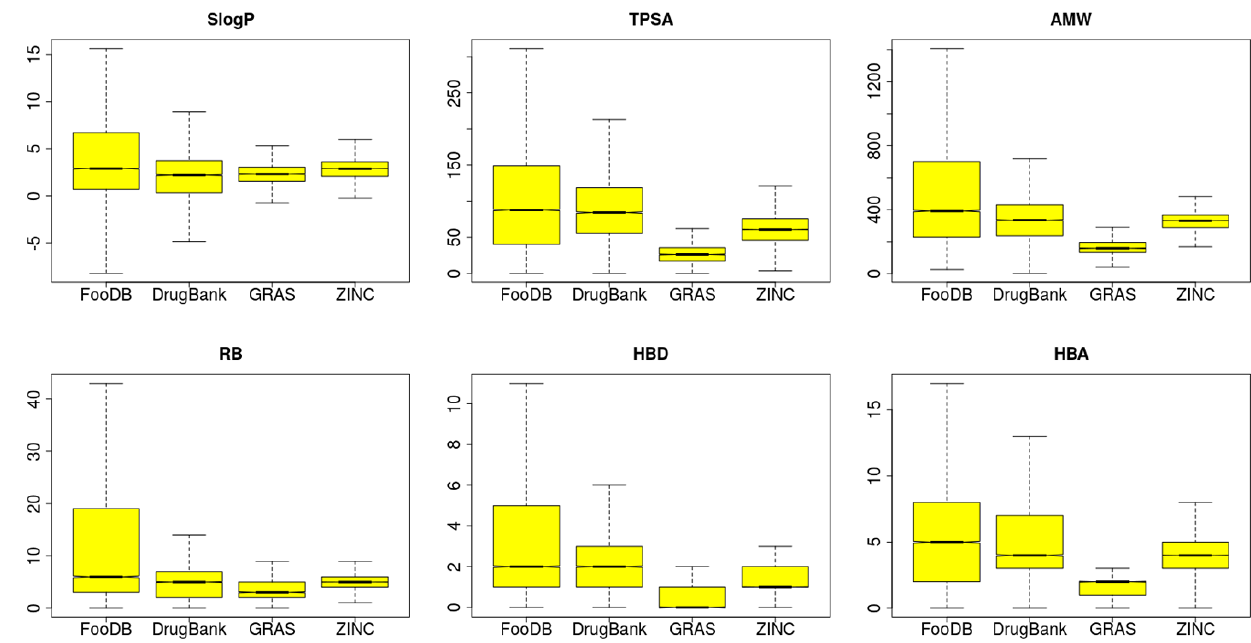
FooDB.Figure 2. Distribution of physicochemical properties. Box plots of the distribution of six physicochemical properties of FooDB and reference data sets. SlogP (partition coefficient), TPSA (topological polar surface area), AMW (atomic mass weight), RB (rotatable bonds), HBD (hydrogen bond donors) and HBA (hydrogen bond